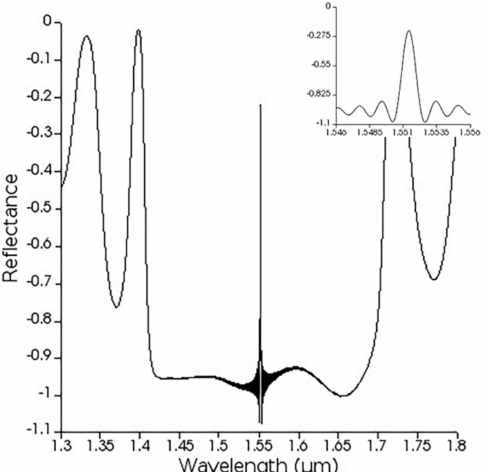
Figure 5. The simulated reflectance result of a single 1D PhC.